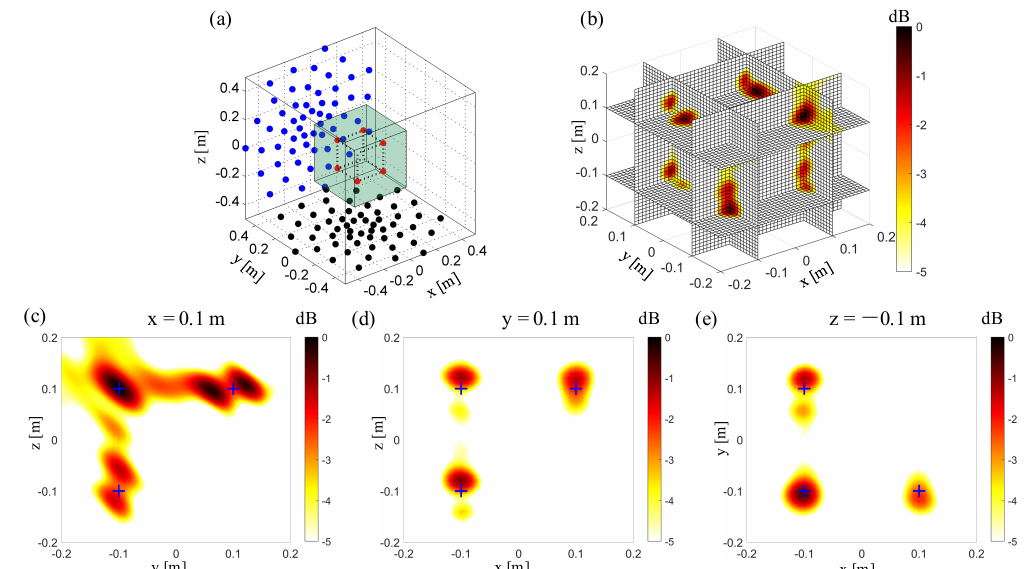
Figure 7. 3D Beamforming results from the non-synchronous measurements, orthogonally moving the array once. ( a ) The simulation setup. The red points “ · ” represent the sound sources. The other same color represents the microphones in the same test. The black points “ · ” represent the microphones in a single planar array test. The blue points “ · ” represent the microphones in the test with the orthogonal moving array, moved here for the first time. ( b ) 3D beamforming map. ( c ) The beamforming map at the x = 0.1 m slice. ( d ) The beamforming map at the y = 0.1 m slice. ( e ) The beamforming map at the z = − 0.1 m slice.